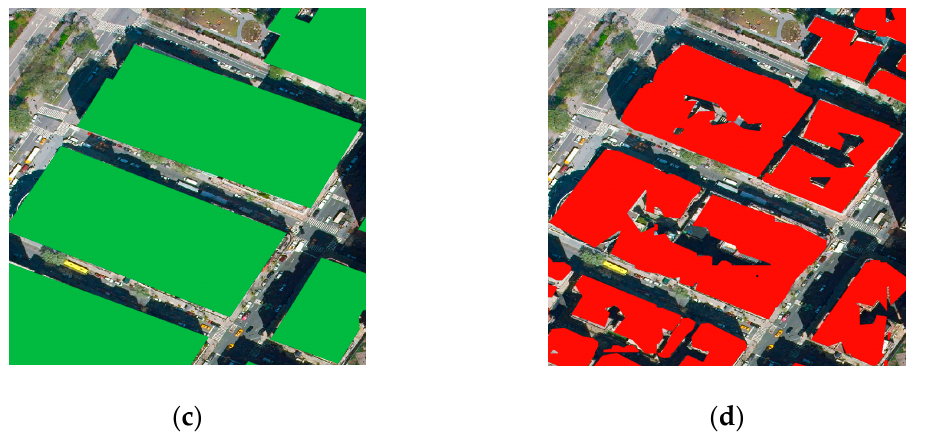
Figure 6. ( a ) Remote sensing image; ( b ) Remote sensing image overlayed with the ground truth mask; ( c ) Remote sensing image overlayed with the Microsoft predicted building footprints; ( d ) Remote sensing image overlayed with the predicted footprints using the proposed workflow based on DeepLabv3+ model (using dicewce loss function).